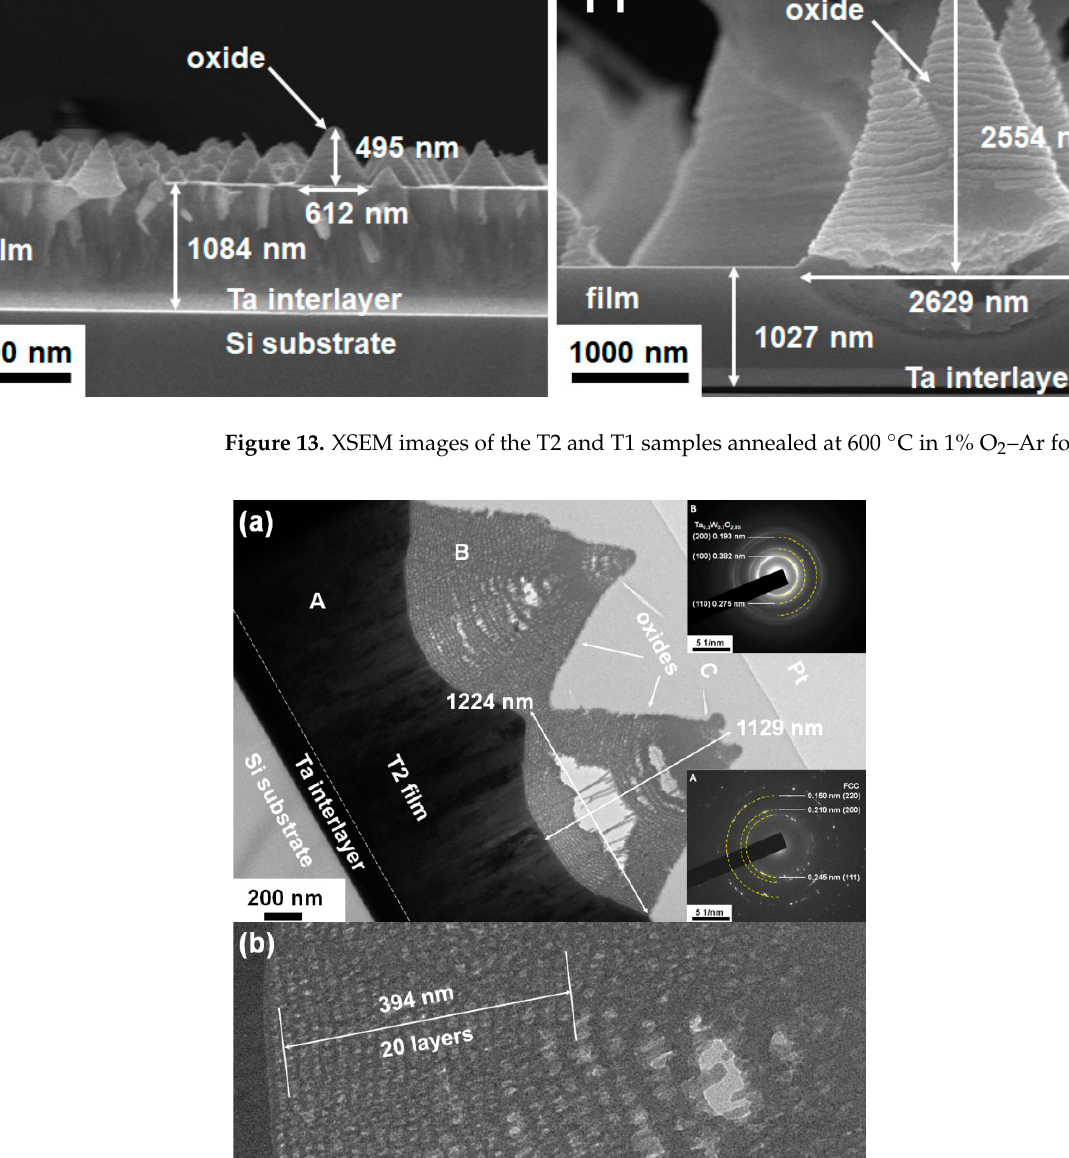
Figure 12. SEM images of the T1 samples annealed at 600 °C in 1% O 2 –Ar for 8 h.